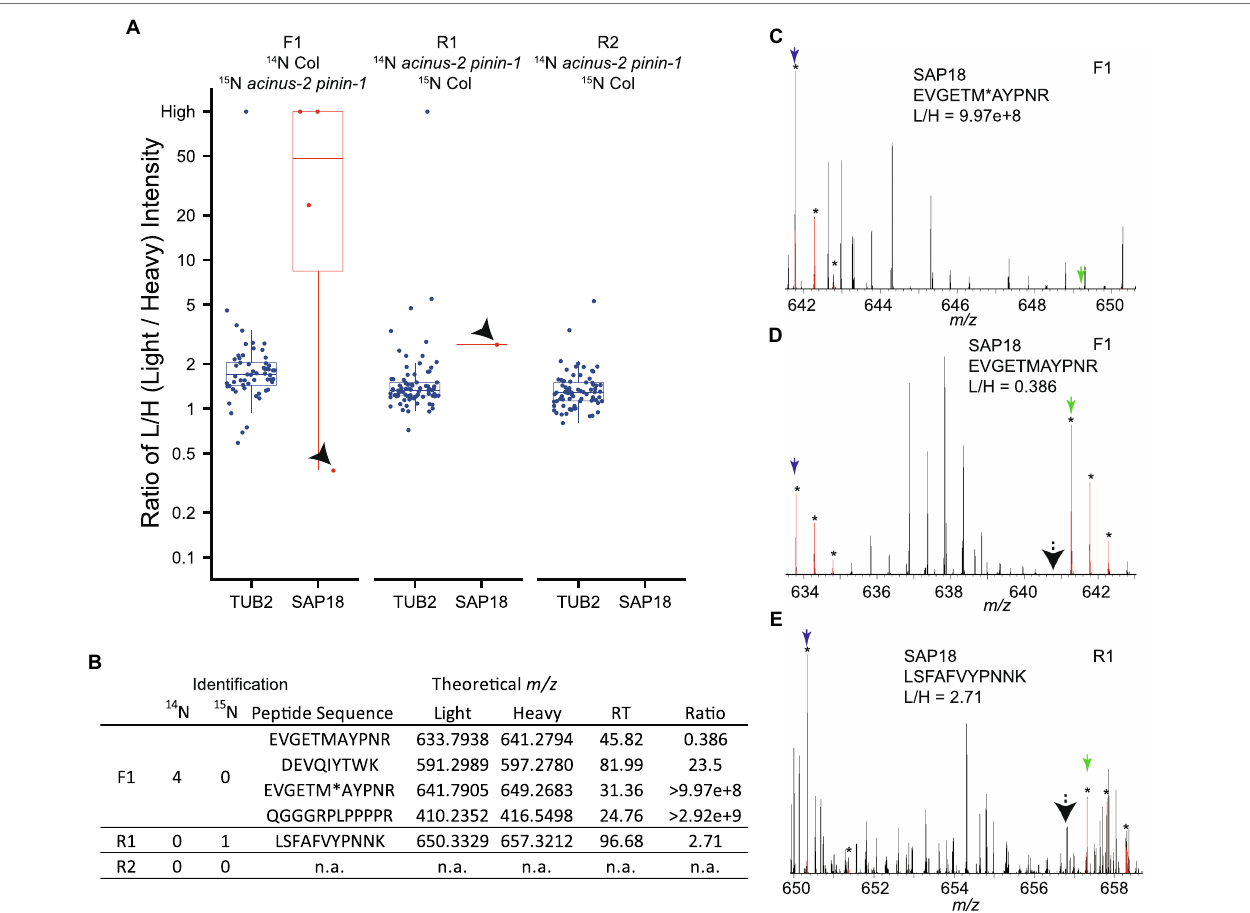
FIGURE 4 | Quantification challenges in 15 N metabolic labeling samples. (A,B) Boxplots of protein ratio measurements from reciprocal 15 N labeling experiments: one forward sample F1 ( 14 N Col/ 15 N acinus-2 pinin-1 ) and two reverse samples R1 and R2 ( 14 N acinus-2 pinin-1 / 15 N Col). Each dot represents the ratio for a single peptide identified to each protein. TUBULIN2 is quantified in all three experiments based on many peptides, while SAP18 is quantified in two of three experiments (F1, R1), with inaccurate quantification in R1, and no quantification in R2. (C) Spectrum showing correct quantification of 14 N and 15 N pair for peptide “EVGETM (oxidation)AYPNR” from SAP18 protein in the F1 sample. (D) Quantification for peptide “EVGETMAYPNR” is inaccurate because the 15 N matching peak is contaminated with a co-eluting peptide in F1 sample. (E) Quantification for peptide “LSFAFVYPNNK” is wrong as the matching 14 N peak is contaminated with overlapping peaks. M, M + 1, and M + 2 peaks labeled with star (*) are highlighted in red by Protein Prospector software; blue and green arrows point to 14 N and 15 N monoisotopic (M) peaks, respectively; and black arrows in (D,E) point to M-1 peak